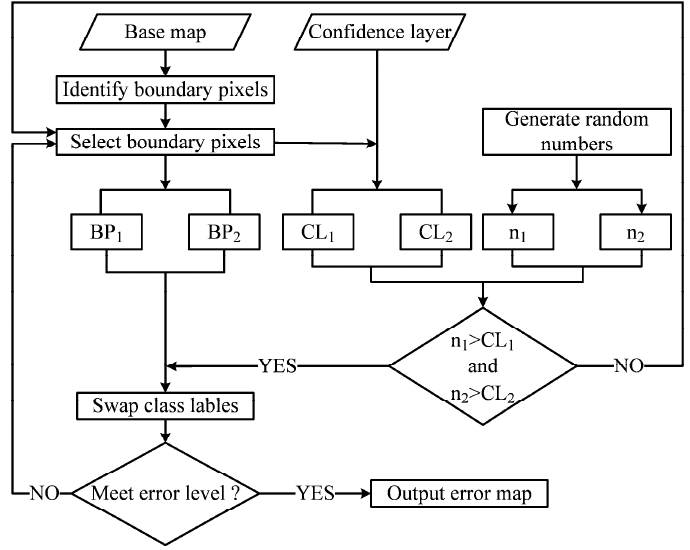
Figure 2. General procedure for producing error map using MC simulation method. BP 1 and BP 2 are boundary pixels randomly selected from the land cover map. CL 1 and CL 2 are the confidence level corresponding to BP 1 and BP 2 . n 1 and n 2 are two numbers randomly generated from a uniform distribution ranging [0, 1].